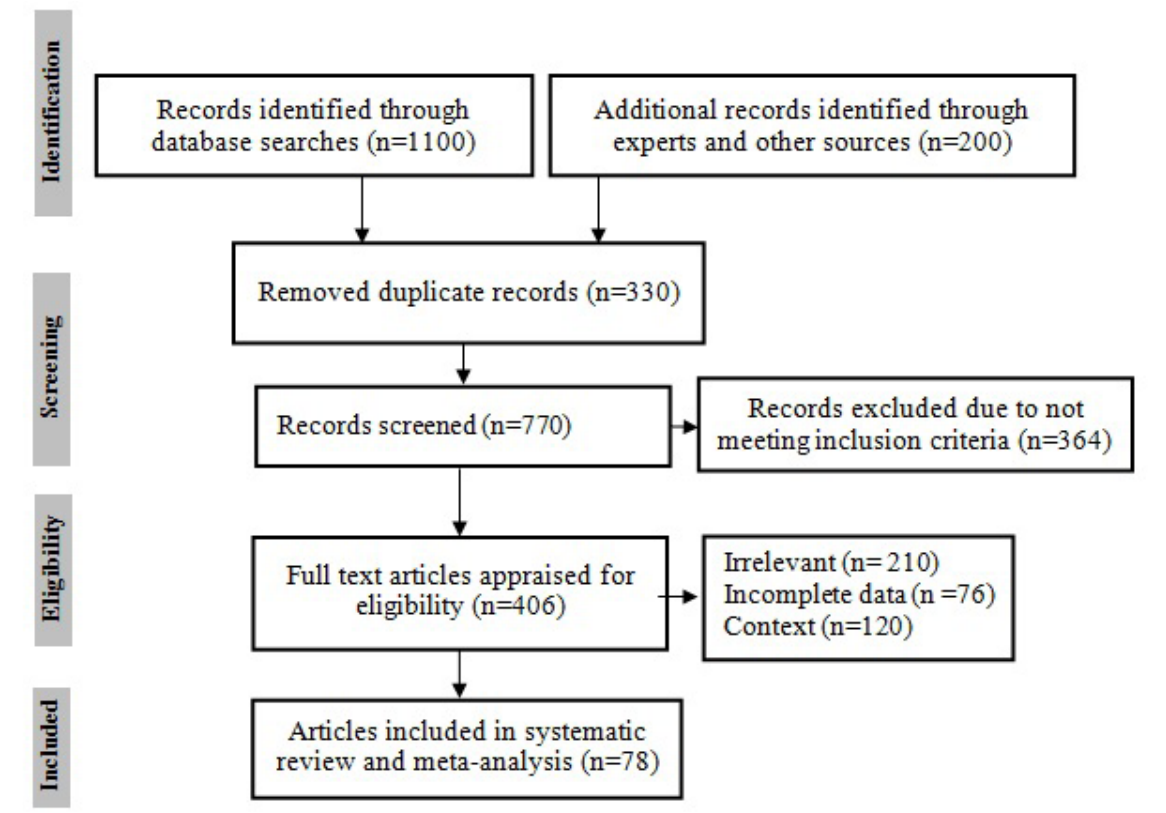
Figure 1. PRISMA flowchart showing the study design process.